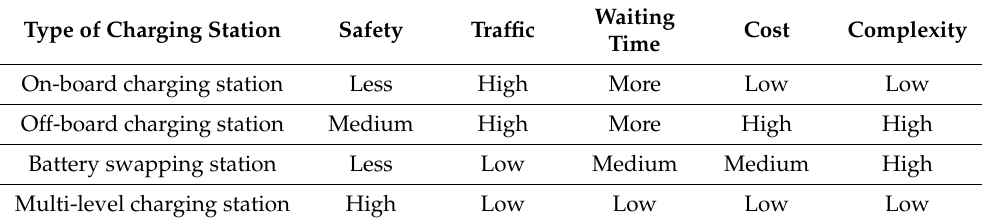
Table 5. Comparisons between Existing charging stations and Multilevel charging